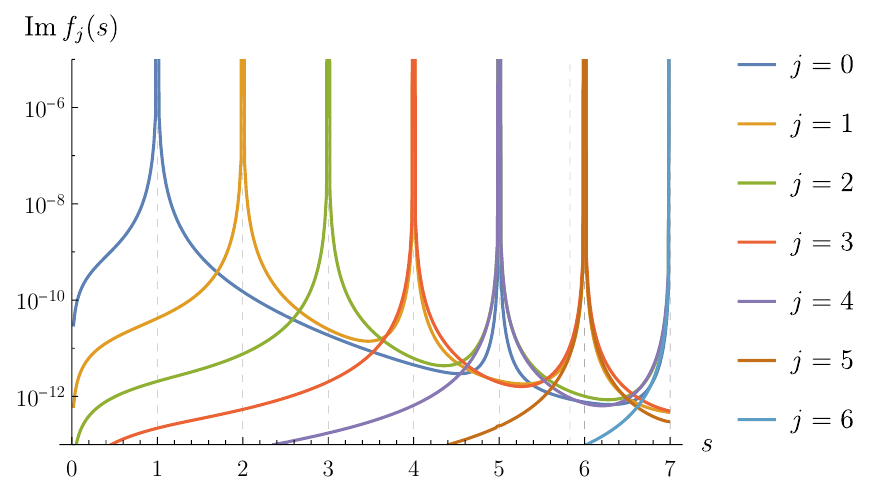
( s ) for first few spins j . j